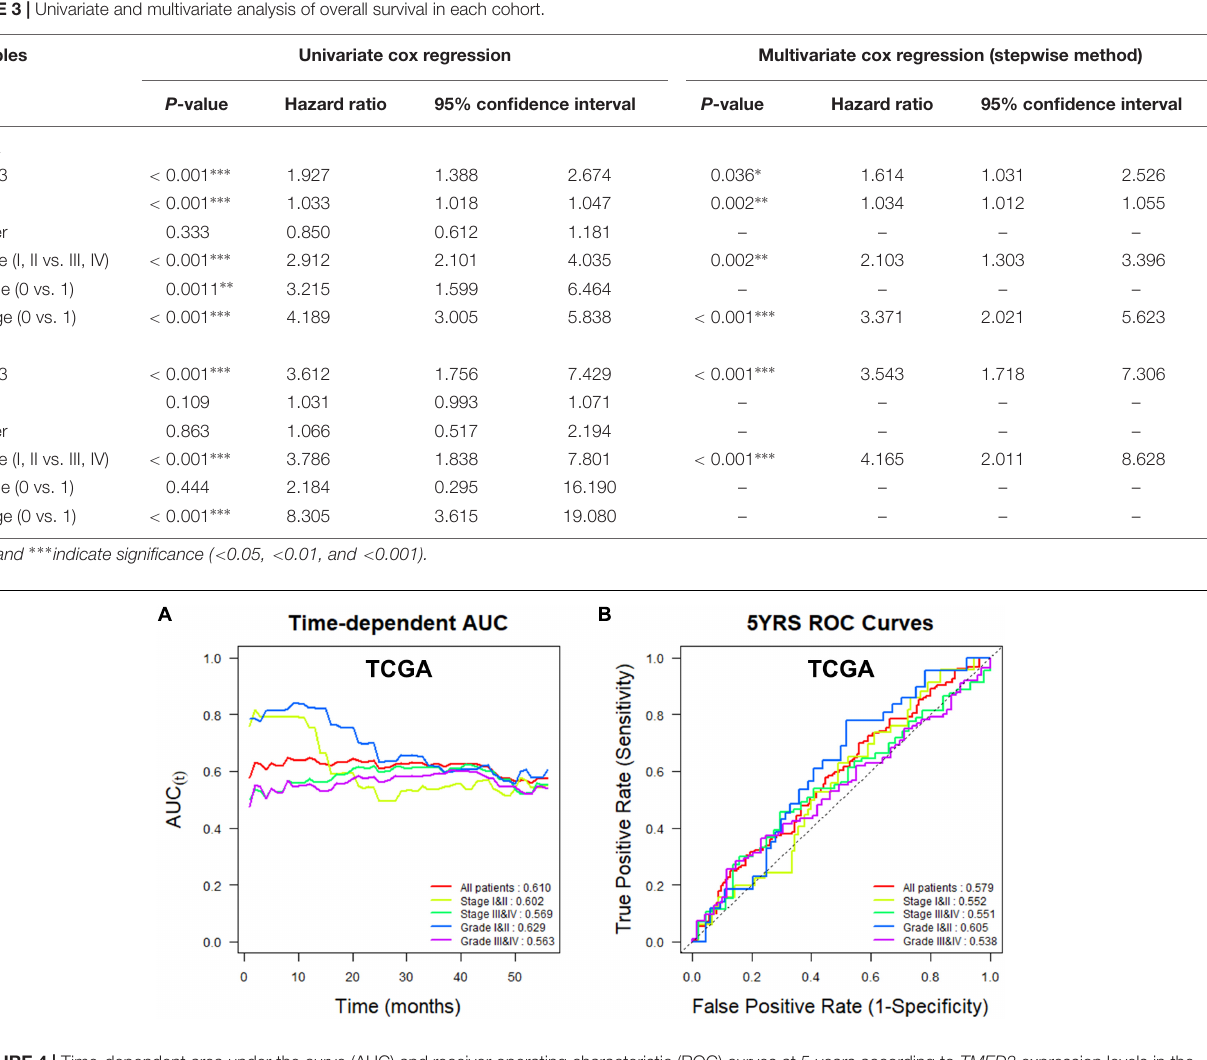
Frontiers in Genetics |